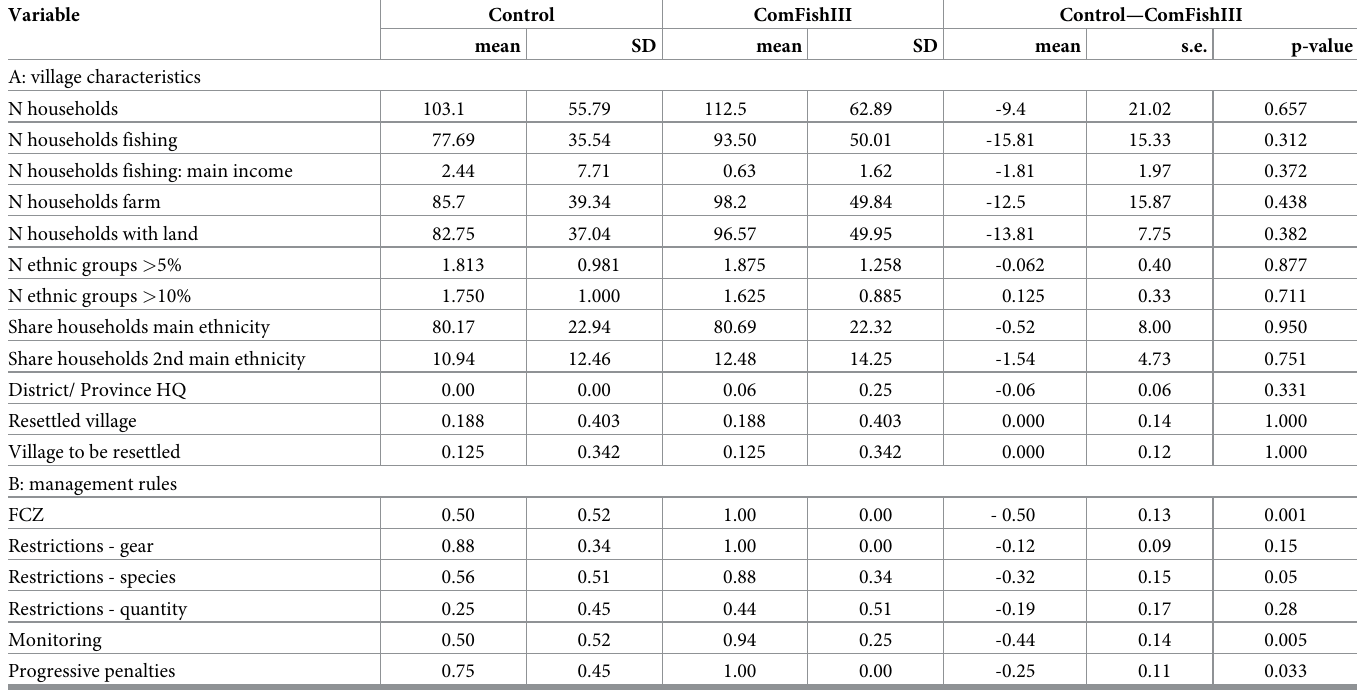
Table 1. Control vs ComFishIII